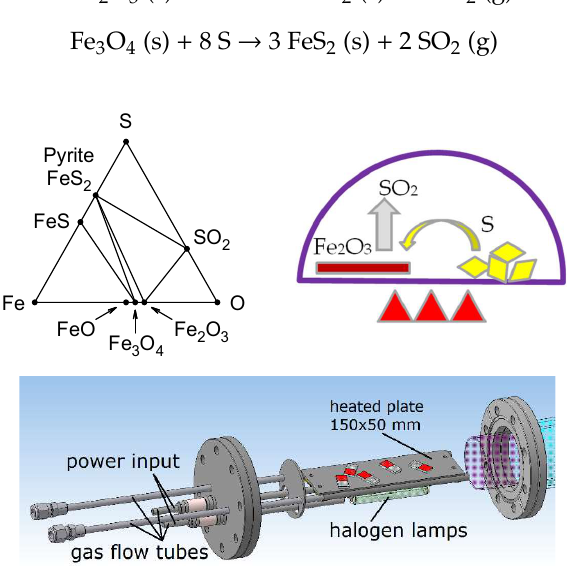
Figure 1. Fe-O-S phase diagram (top left), schematic of iron oxide sulfidation at a temperature of about 350 °C and atmospheric pressure (top right); and 3D model of the vacuum mini furnace for the iron oxide sulfidation of samples used in this article (bottom).